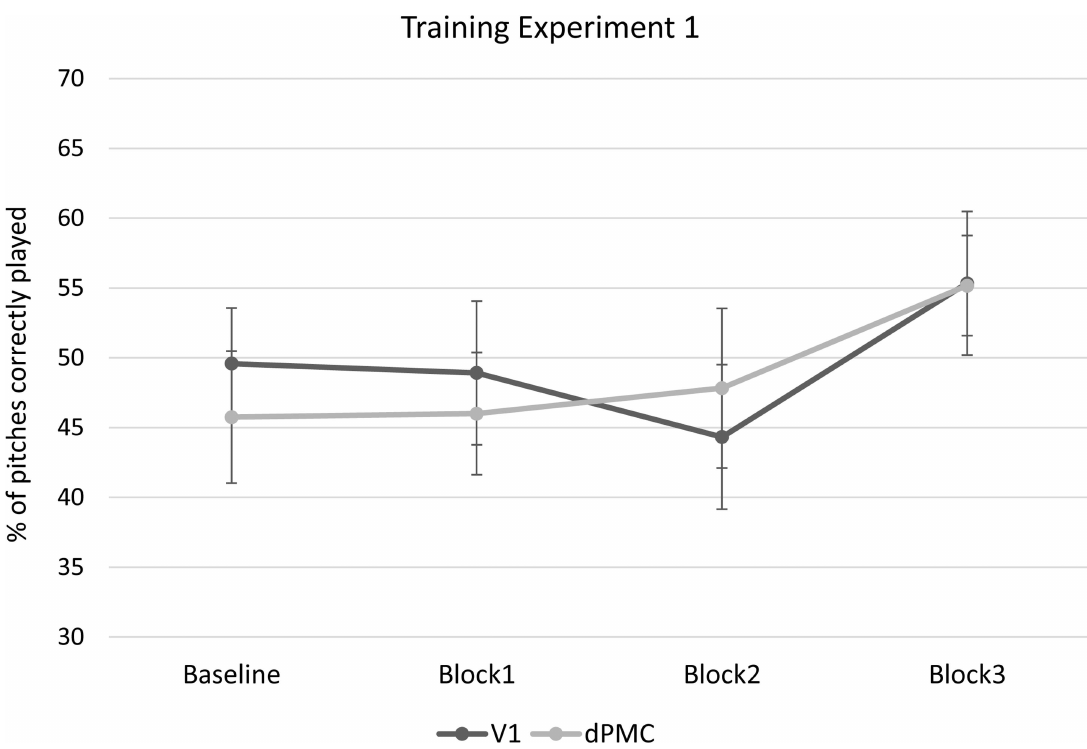
Fig 5. Results of the training phase of the study of Experiment 1. Graph represents the percentage of pitches correctly played plotted across blocks of trials (Baseline, Block 1, Block 2 and Block 3) for the dPMC and the V1 groups. Error bars represent ± 1